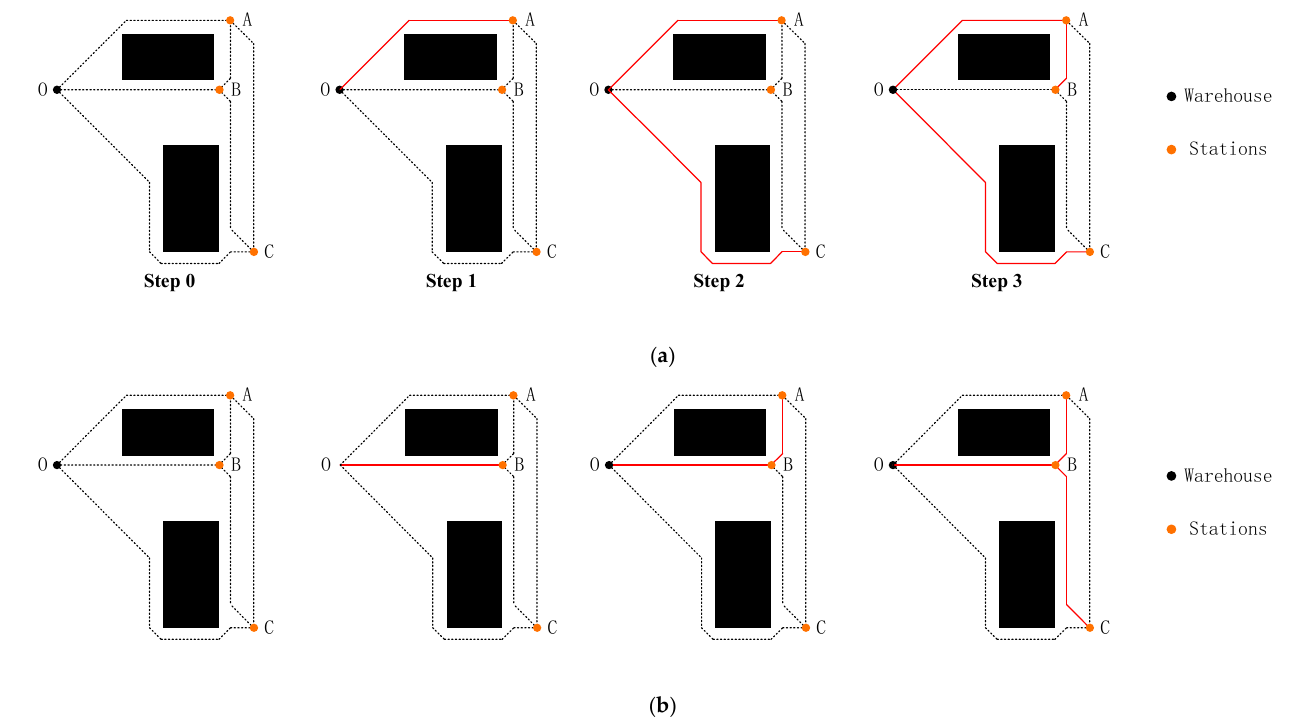
Figure 6. Public air-route planning process. ( a ) Public air-route planning sequence of A–C–B. ( b ) Public air-route planning sequence of B–A–C.